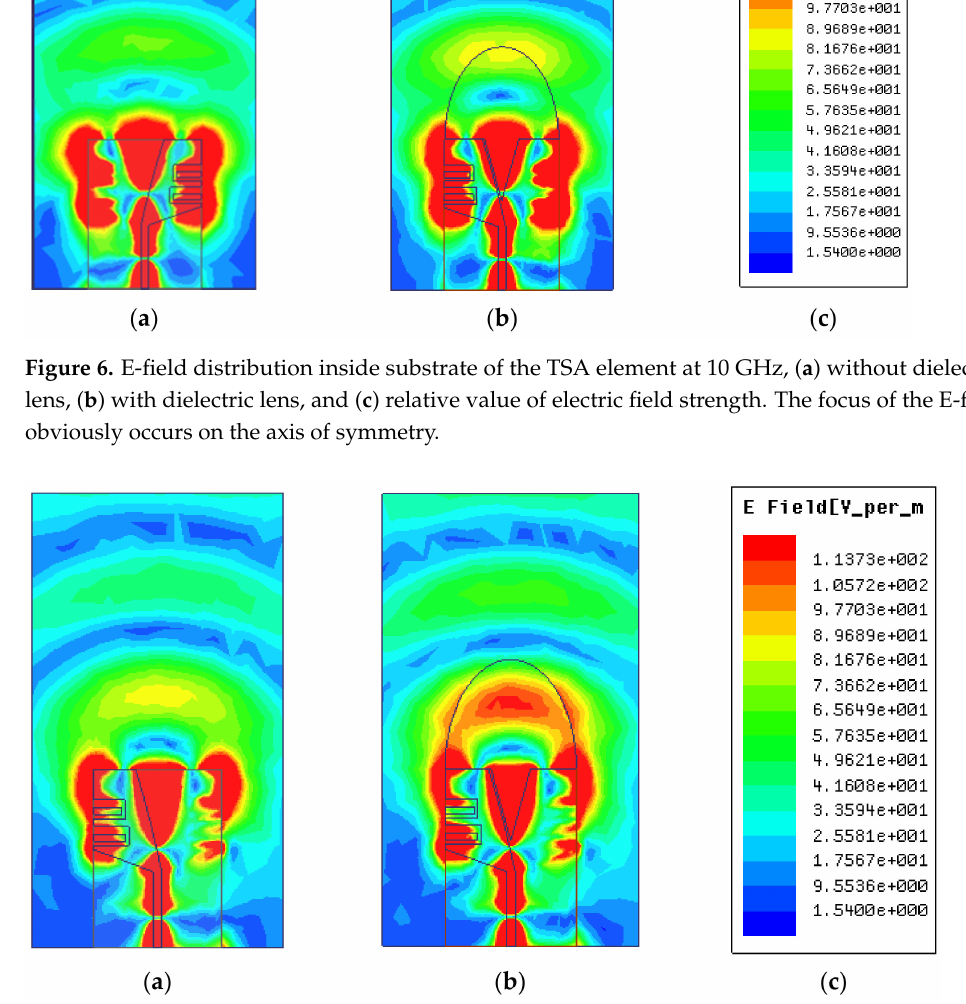
Figure 7. E-field distribution inside substrate of the TSA element at 11 GHz, ( a ) without dielectric lens, ( b ) with dielectric lens loaded, and ( c ) relative value of electric field strength. The same summary is obtained in Figures 2 and